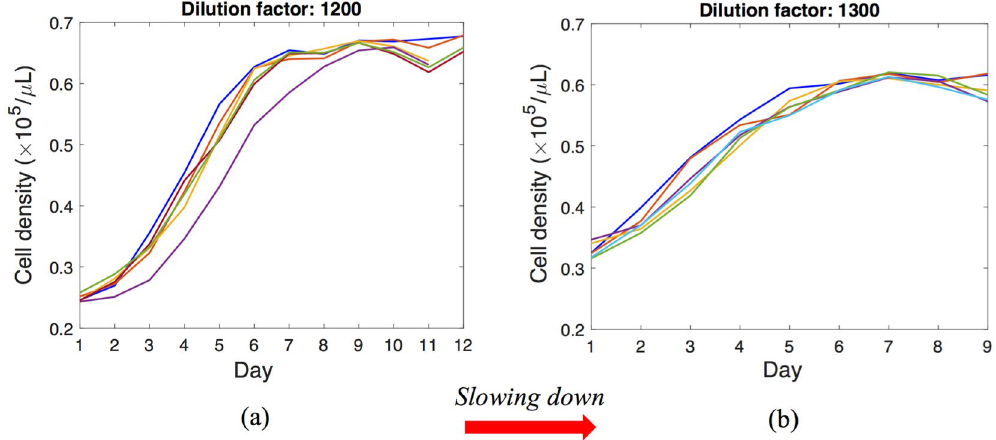
Figure 4. Measured recoveries of the yeast population from perturbations at: ( a ) a dilution factor 1,200; ( b ) a dilution factor 1,300, while the system approaches to the tipping point from parameter values smaller than the critical parameter. Each line represents a separate experiment, and each experiment has 7 replications which are performed simultaneously using the same source of materials at exactly the same experimental conditions. The system slows down while approaching the critical transition, namely as the dilution factor increases from 1,200 to 1,300 (changing from ( a ) to ( b )). These measurements are used to forecast the bifurcation diagram which corresponds to the schematic shown in case ( a ) of Fig.